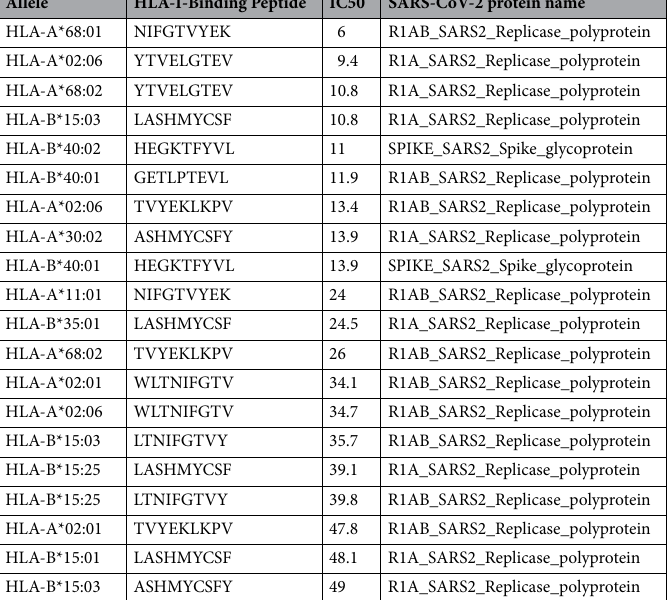
Table 3. HLA-I binding high confidence (IC50 < 50 nm) SARS-CoV-2 antigenic peptides (pipeline 2).